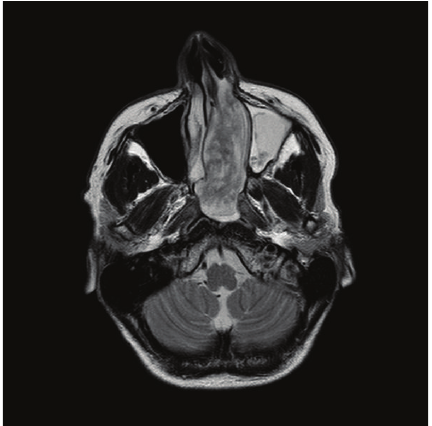
Figure 1: CT (axial view) showing complete opacification of left frontal, ethmoid, maxillary, and sphenoid sinuses and nasal cavity.